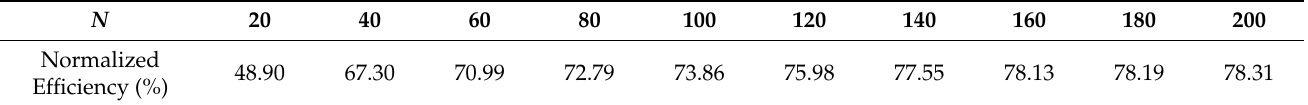
Table 4. Variation of the collection efficiency with different N .